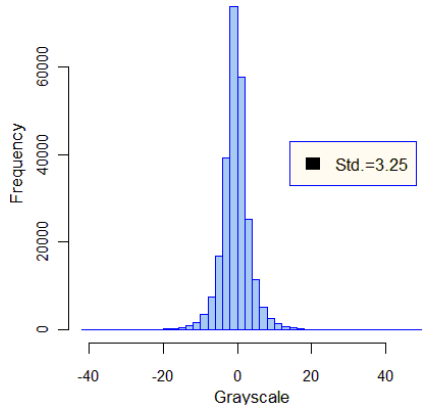
Figure 4. Grayscale histogram of the differential